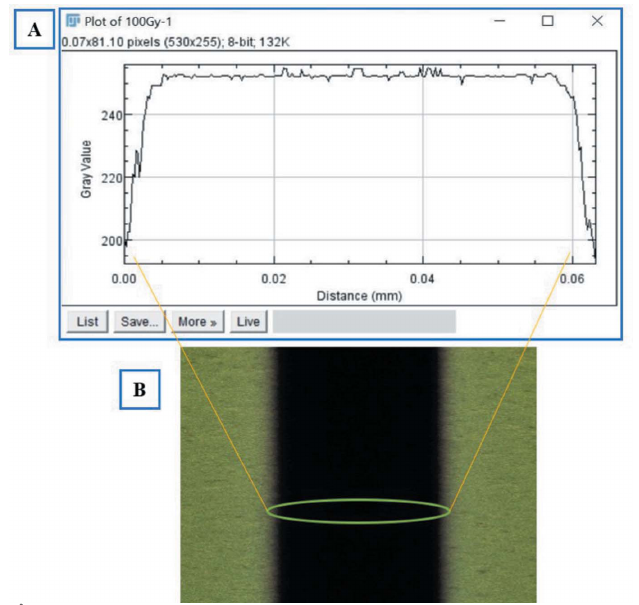
Figure 5 Radiation field exposed to 100 Gy of 90 kV SBB. (A) Dose profile plotted by ImageJ # and (B) GAFchromic TM HD-V 2 film.